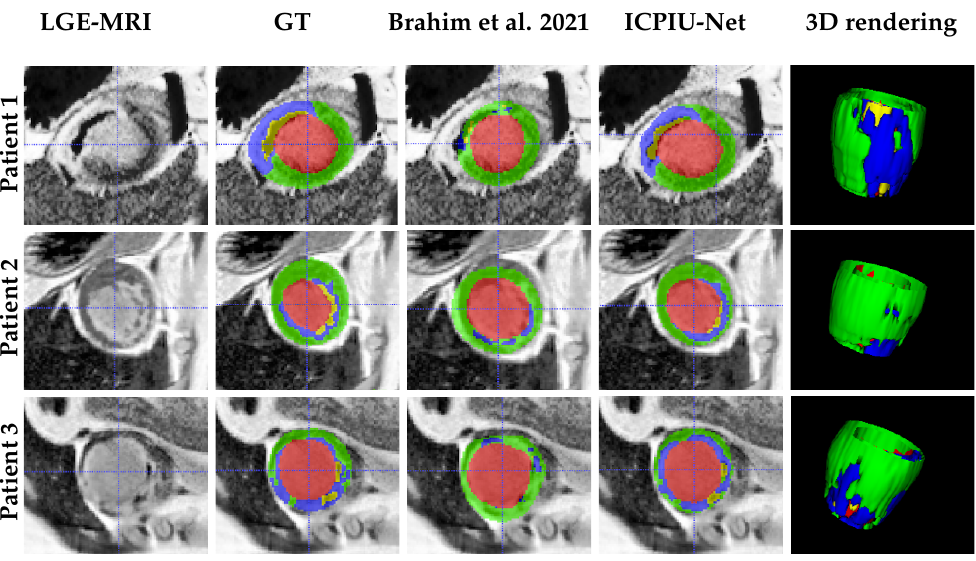
Figure 5. Qualitative results. In the first four columns, input LGE-MRI, manual delineations, and exemplary test results of the segmented myocardial regions in three slices extracted from LGE-MRI of three patients generated by the Brahim et al. [61] method and our ICPIU-Net approach are shown. The fifth column illustrates the 3D view of the myocardial tissues of our proposed method prediction. LV cavity is displayed in red, LV myocardium is in green, infarct in blue, and MVO in